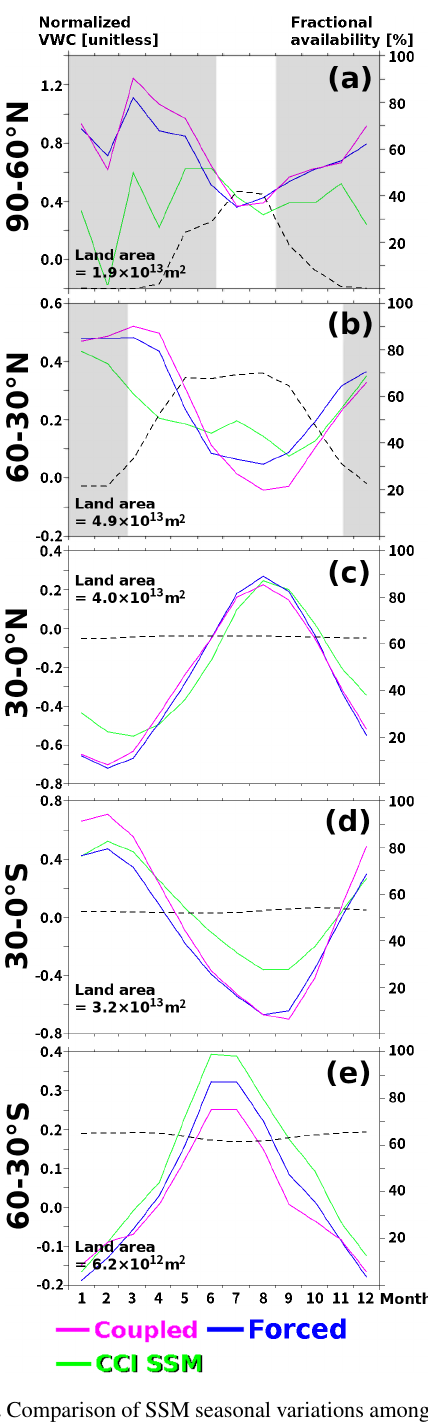
Figure 4. Comparison of SSM seasonal variations among reference (CCI-SSM) and simulations (forced and coupled) for each latitude zone. The dashed black line is the fraction of available pixels to all land pixels over each zone. Depending on the snow mask, the number of available pixels varied along the season in high-latitude regions. To avoid a misleading interpretation, a small number of samples with unreliable SSM reference and periods of less pixel availability ( < 30%) are grayed out.